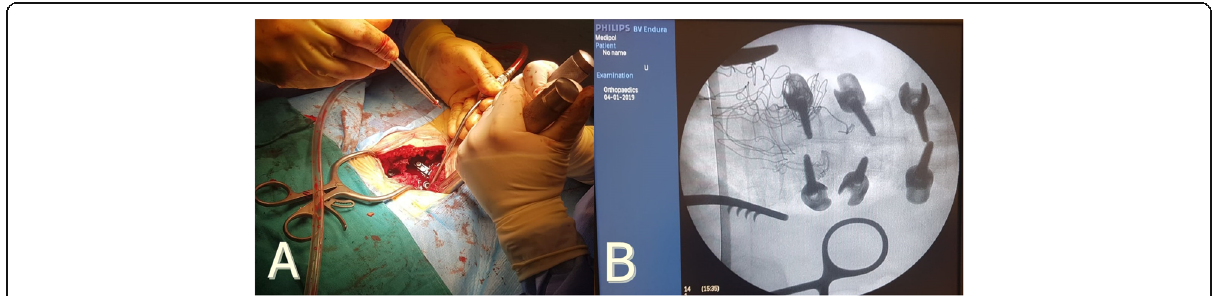
Fig. 1 a Surgery of multi-level spinal fusion. b X-ray photograph of multi-level spinal fusion